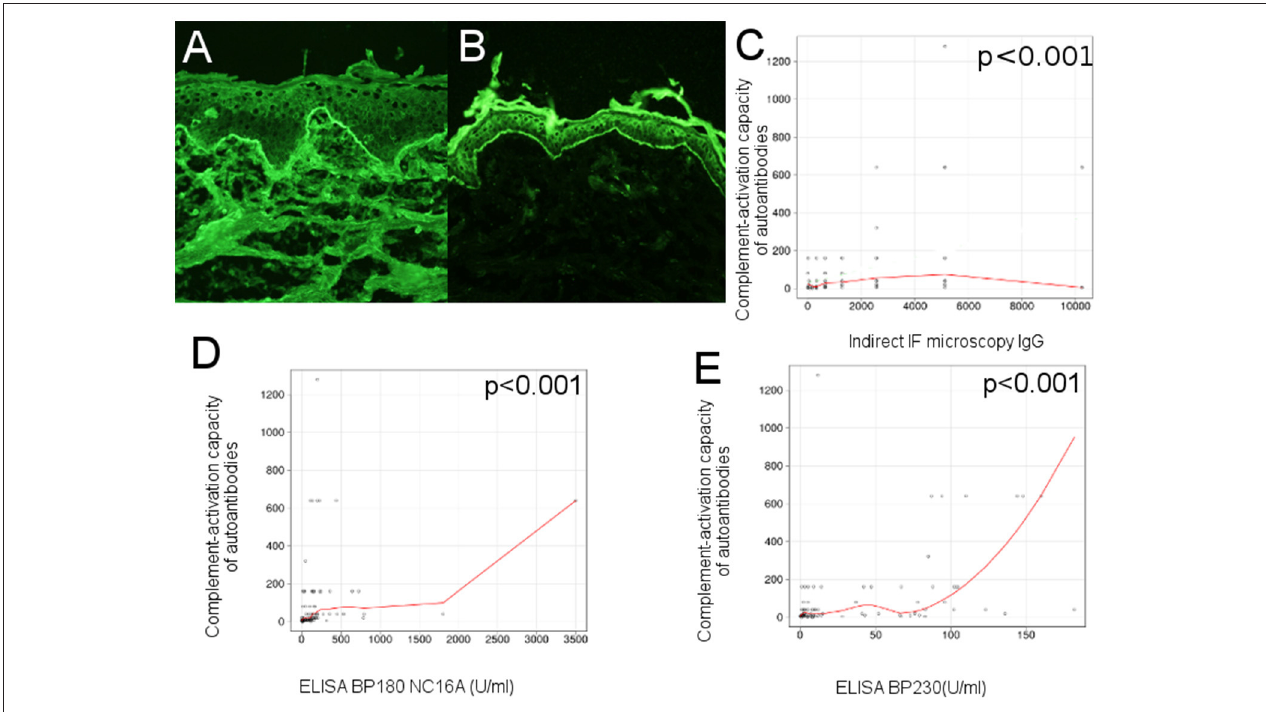
FIGURE 2 | Complement-activation potential of circulating IgG anti-basement membrane zone autoantibodies correlates with their levels in bullous pemphigoid patients. (A) Indirect immunofluorescence microscopy on normal human foreskin shows binding of IgG autoantibodies from the serum of a BP patient at the dermal-epidermal junction. (B) Complement-binding test shows linear C3 deposits along the basement membrane of normal human foreskin, when using serum from a BP patient, demonstrating activation of complement by IgG autoantibodies. Relation of ex vivo complement-activating capacity of autoantibodies and (C), titers of circulating IgG anti-basement membrane zone autoantibodies, measured by indirect IF microscopy; (D), titers of circulating IgG anti-BP180 NC16A, measured by ELISA; (E), titers of circulating IgG anti-BP230, measured by ELISA ( n = 90). The red line represents the locally weighted scatterplot smoothing